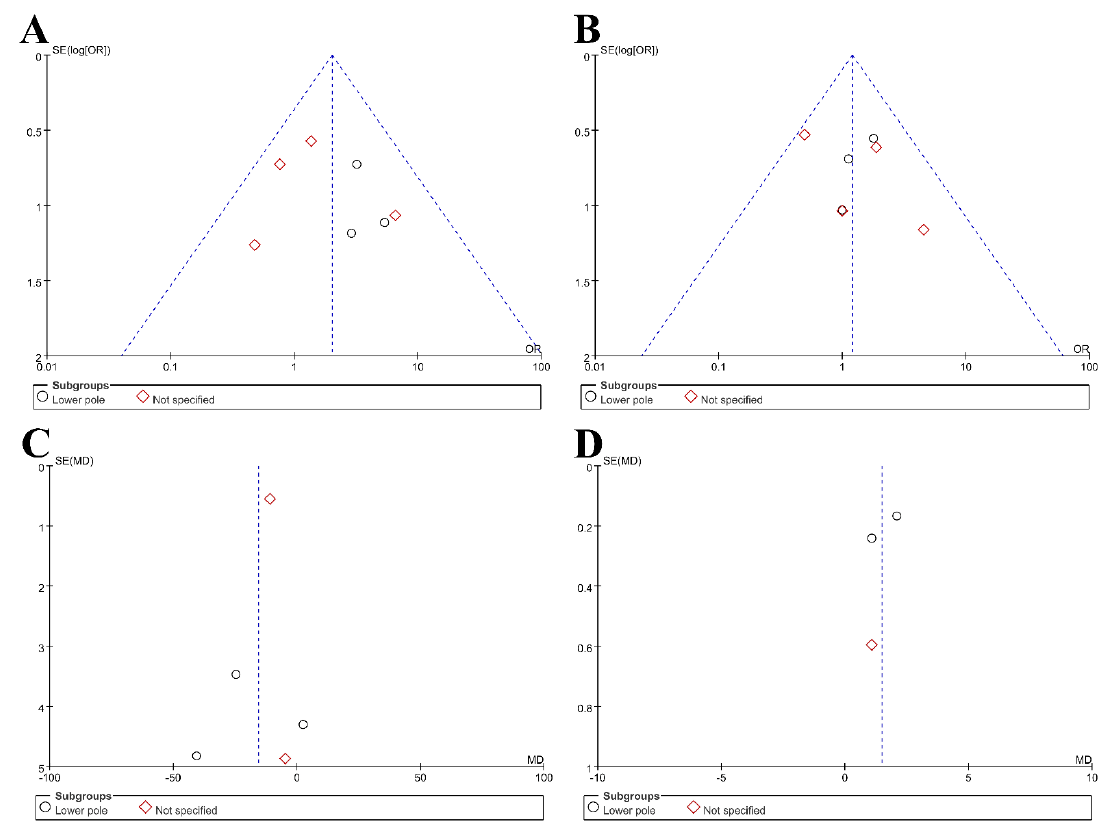
Figure 2. Funnel plots: ( A ) stone-free rate (SFR); ( B ) complication rate; ( C ) operative time; ( D ) hospital stay.